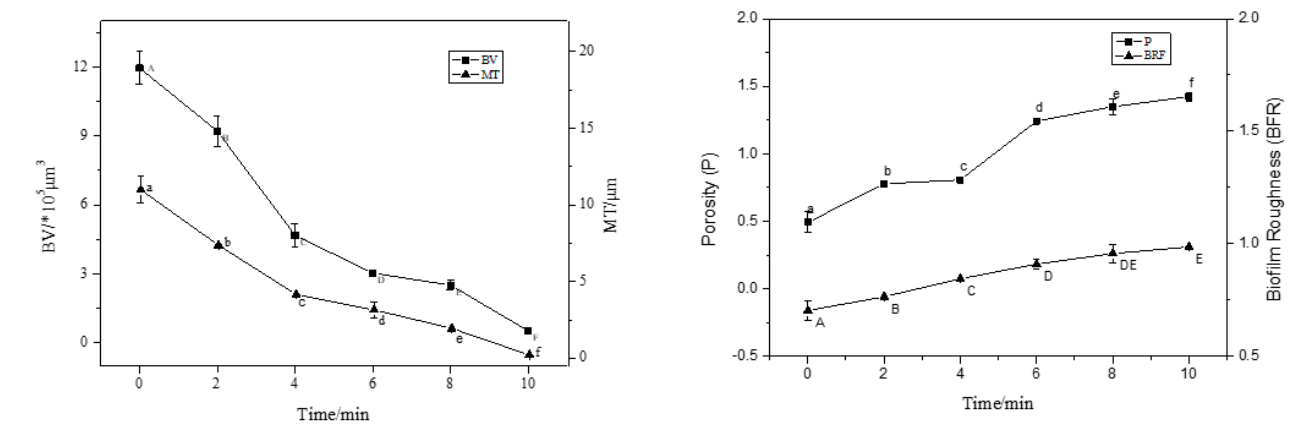
Figure 5. The CLSM images analysed by ISA-2 software to determine the biovolume (BV), mean thickness (MT), porosity (P) and biofilm roughness (BFR) of the biofilm. Data were expressed by mean measurements ± standard deviation (SD), and all treatments and determinations were performed in triplicate . The different letters indicate significant differences ( p < 0.05).